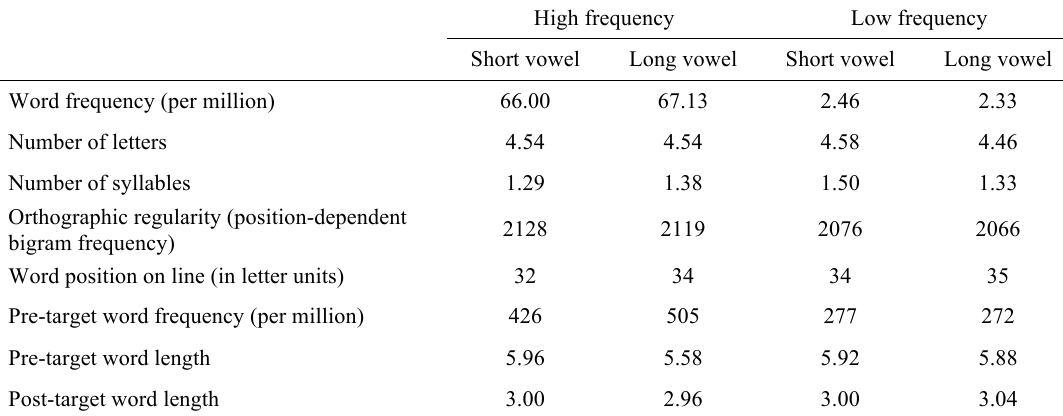
Characteristics of target